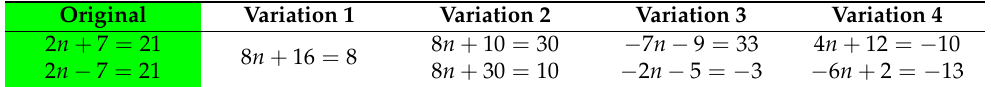
Table 16. Examples of type 7 equation variations with n as the unknown.